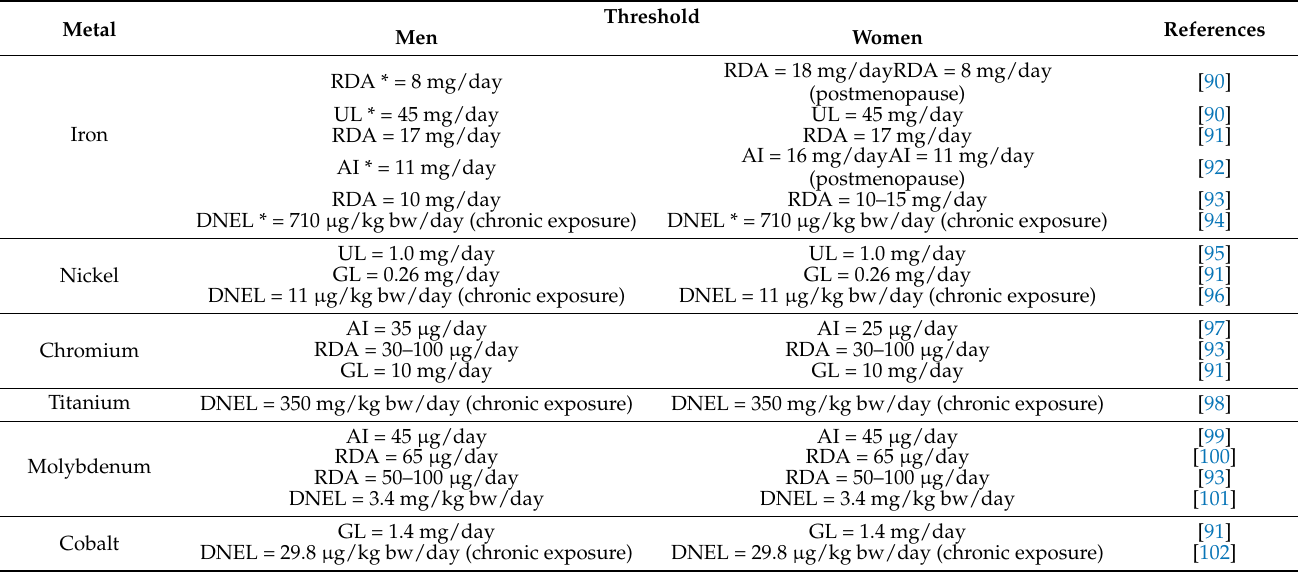
Table 2. Limit intake levels for selected